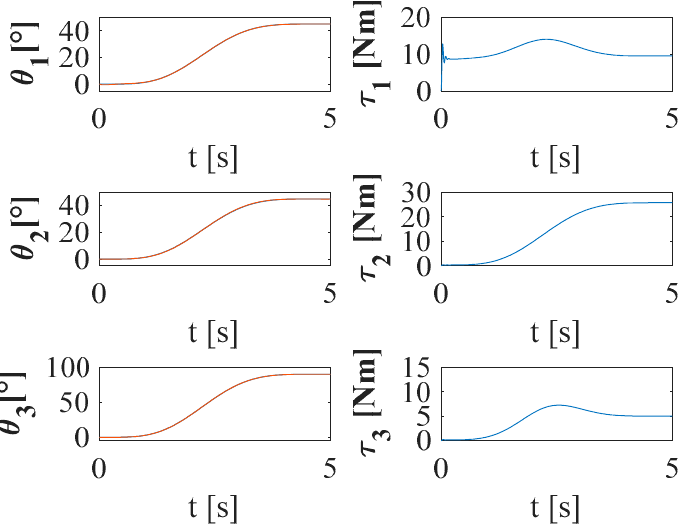
Figure 13. Response for a combined movement with the GPI controller, given by Equation (13), considering the weight of the patient’s arm and elbow flexor torque (spasticity).